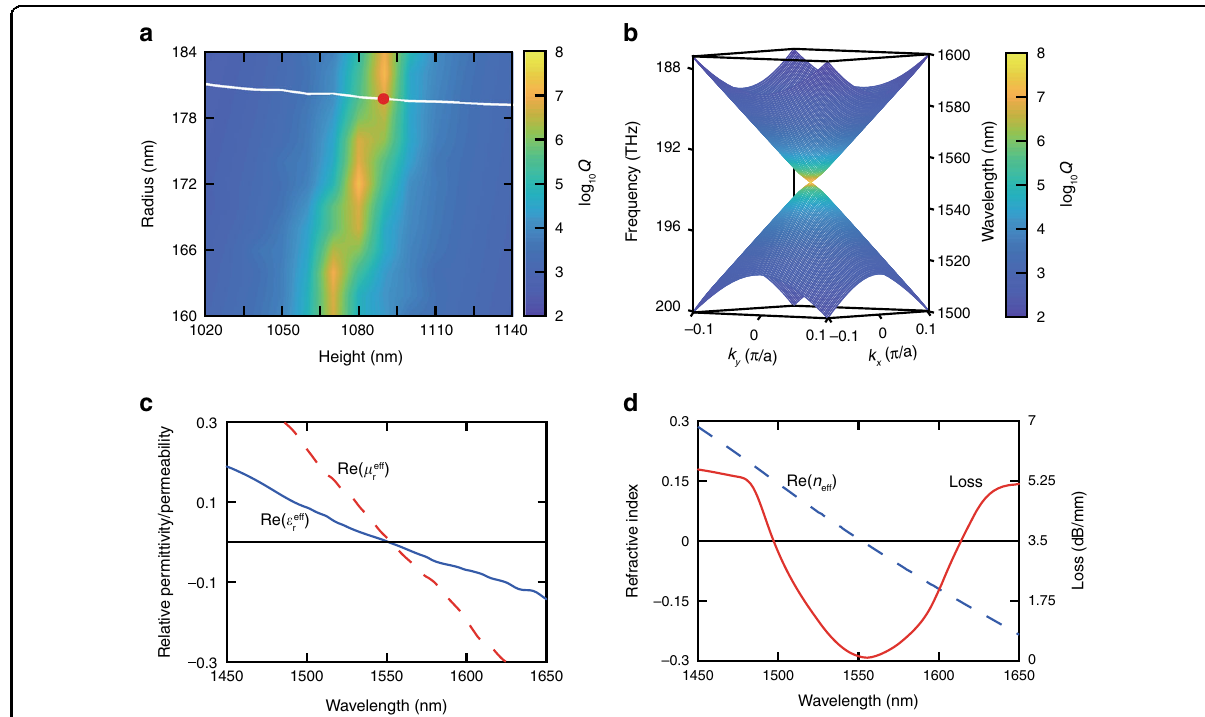
Fig. 5 Optical properties of a BIC zero-index PhC slab. a Parameter sweep for design of a BIC zero-index PhC slab. Quality factor of the dipole mode (colour map) and degeneracy of monopole and dipole modes at the centre of the Brillouin zone (white line) as a function of pillar radius and height (Fig. 2a). The red dot indicates the degeneracy of a monopole mode and a high-Q dipole mode. b Three-dimensional dispersion surfaces showing the Dirac-cone dispersion corresponding to the optimized parameters at the red dot in ( a ). c Effective relative permittivity and permeability of the optimized design. Both of them linearly cross zero at 1550 nm. d Effective index and propagation loss of the PhC slab. When the real part of the effective index crosses zero, the loss curve reaches its valley (~0.15 dB/mm), indicating an ultra-low-loss zero